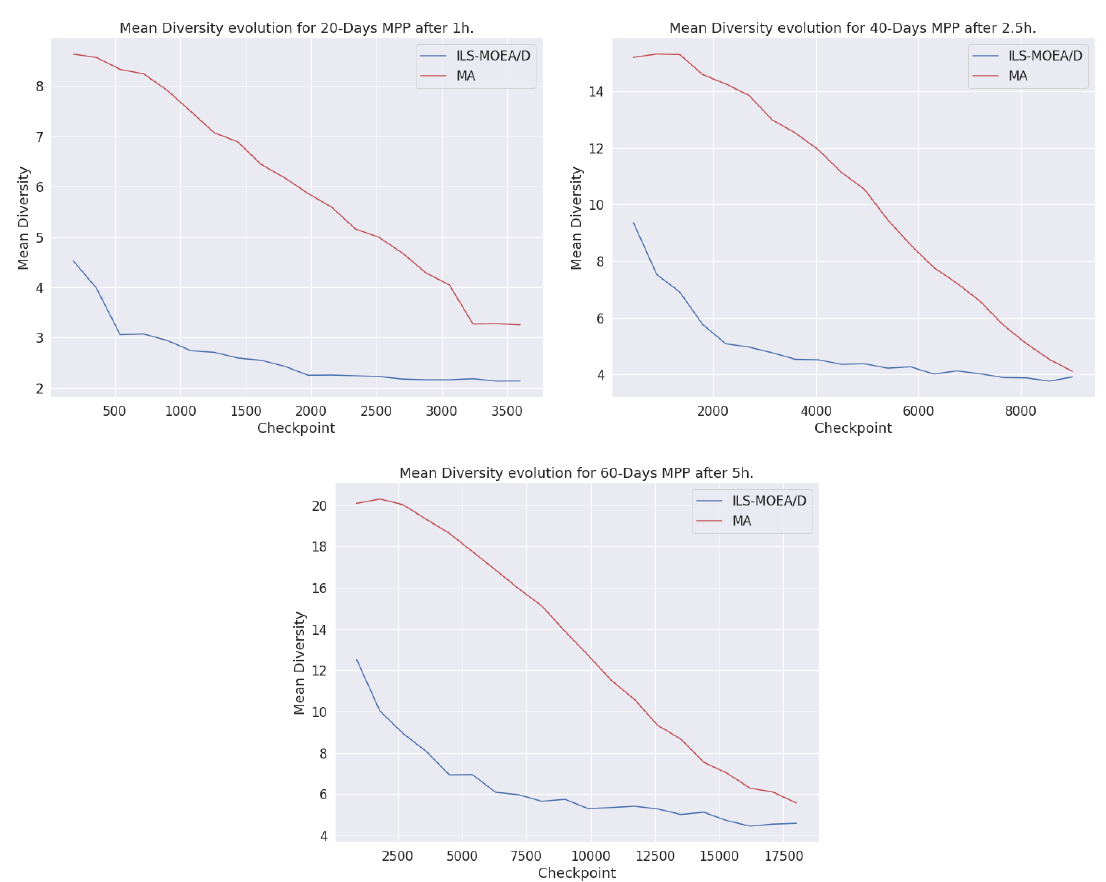
Figure 3. Evolution of the mean diversity of the population in the decision variable space, considering menu plans for n = 20 ( upper-left ), n = 40 ( upper-right ) and n = 60 ( bottom ) days.